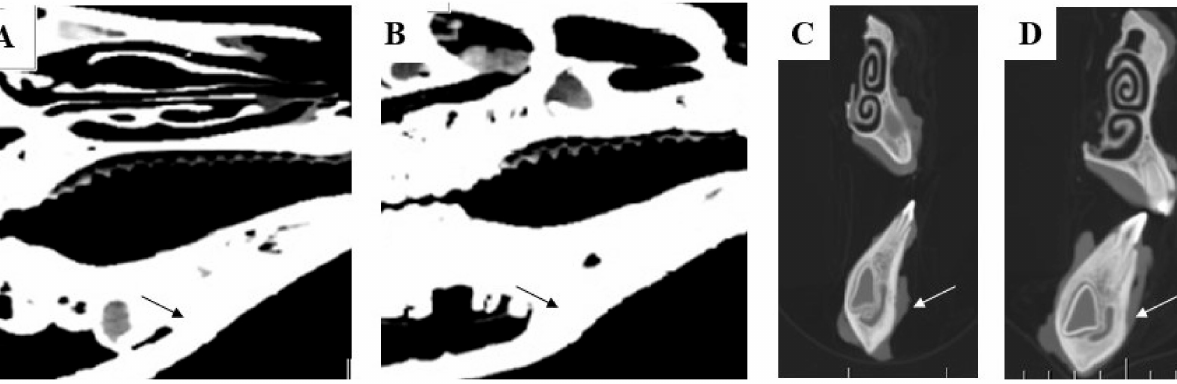
Figure 12. The computerized tomography section demonstrates high resolution of the sagittal plane ( A , B ), Pos: 0.3, Plane: (1.00, 0.00, − 0.00, − 0.28), W: 100, L: 35 and axial plane ( C , D ) Pos: − 21.3, Plane: (0.00, − 0.00, 1.00, 21.25), W: 100, L: 35, which proves the total regeneration of the cortical bone tissue (black and white arrows show the surgical area) after treating with the HAP ceramic plate.